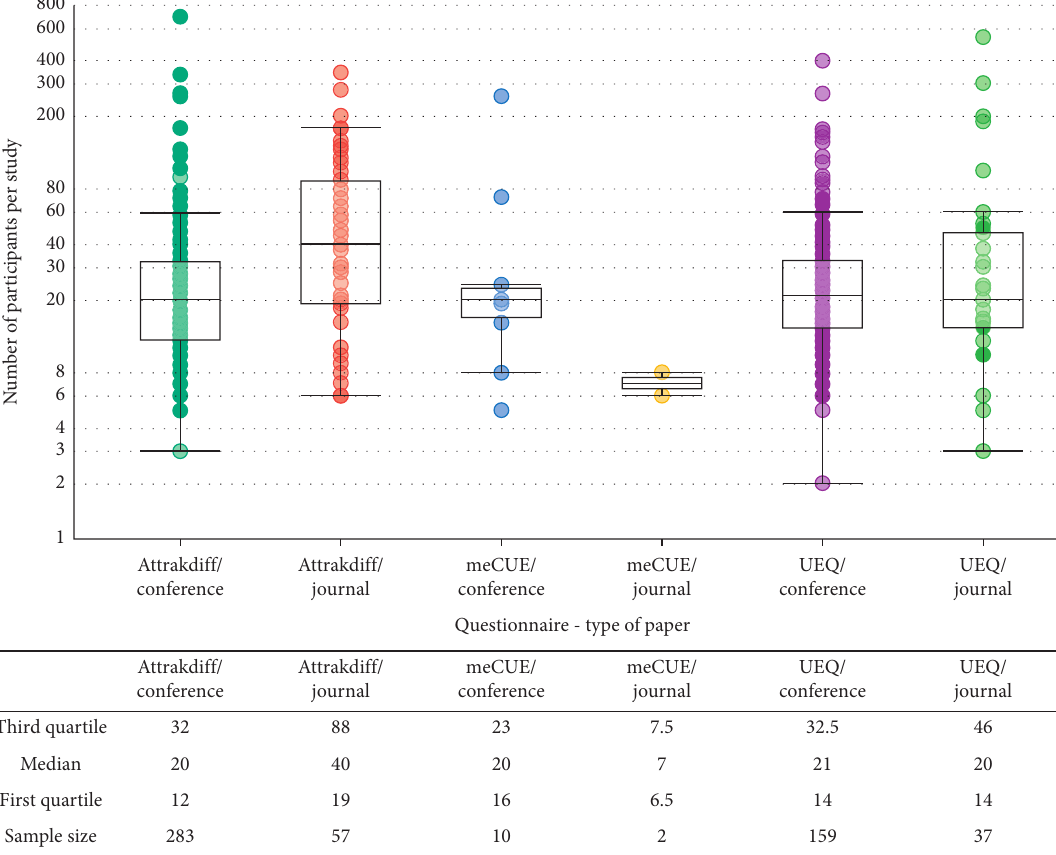
Figure 7: Number of participants per study by standardized questionnaires.